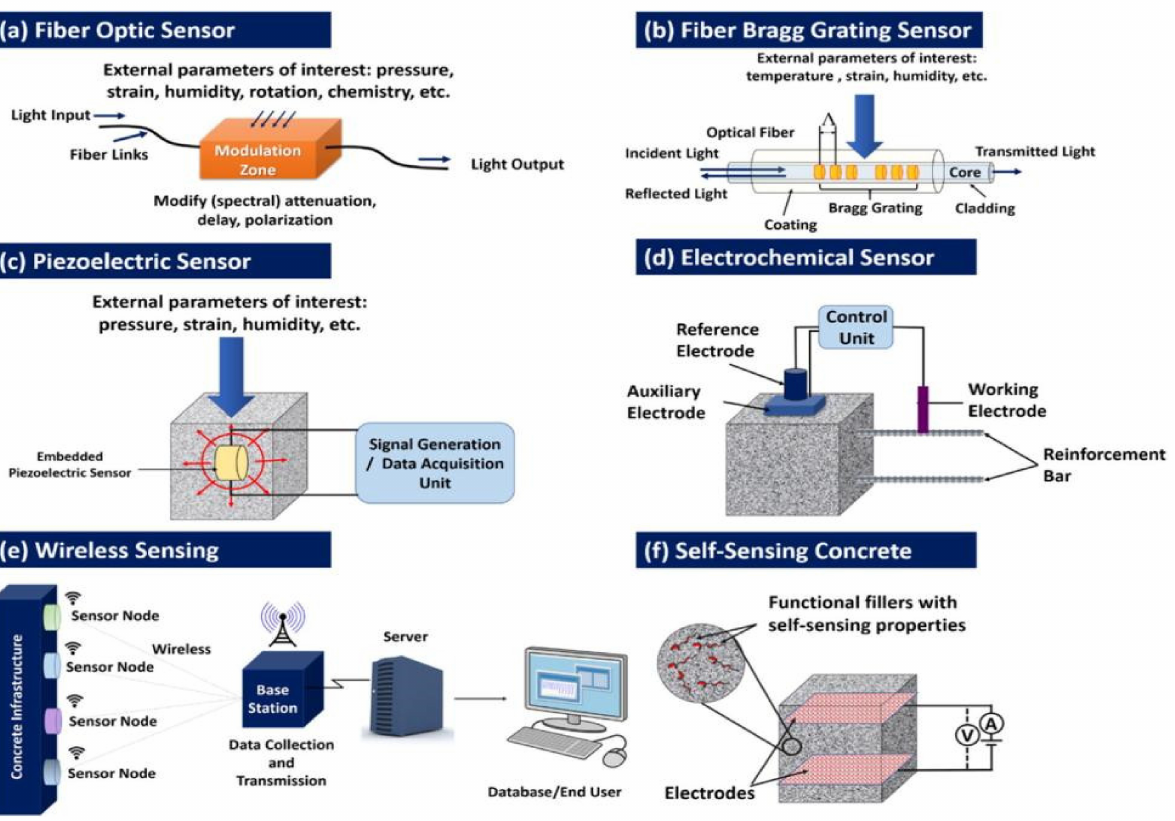
Figure 16. Illustration of a sample ( a ) optical fiber sensor, ( b ) fiber Bragg grating sensor, ( c ) piezoelec- tric sensor, ( d ) electrochemical sensor, ( e ) wireless sensor system, and ( f ) self-sensing concrete